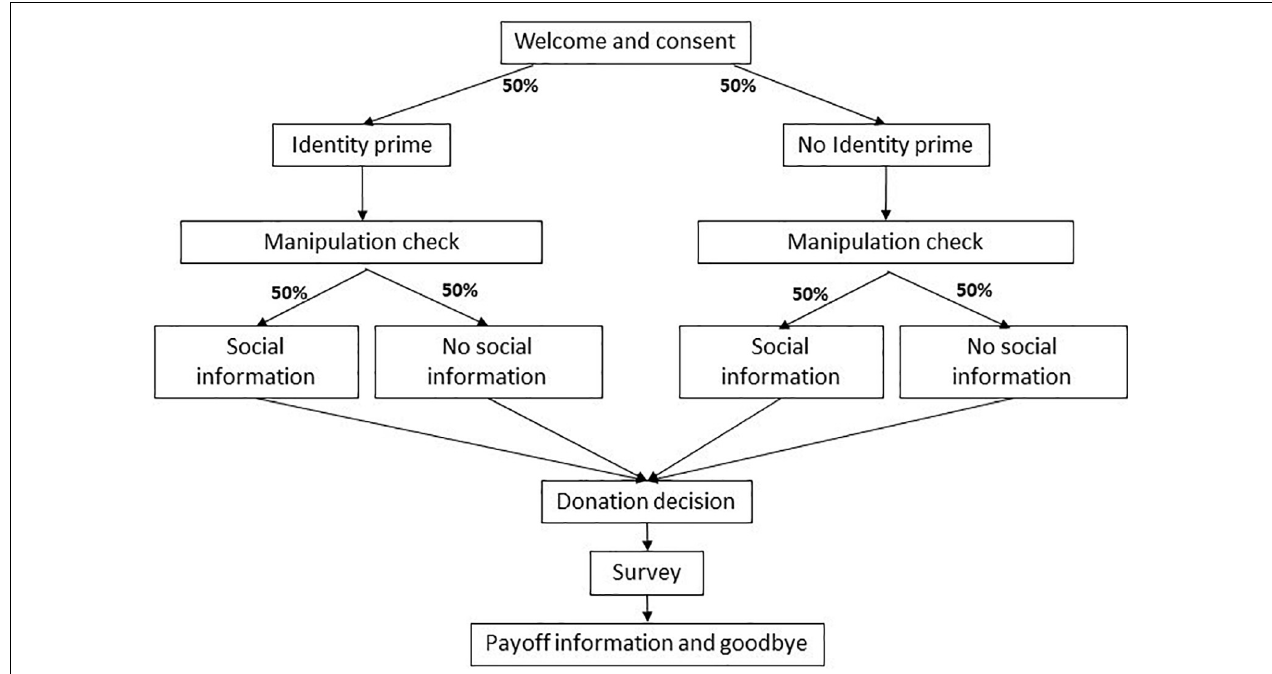
FIGURE 1 | Study 1 experimental